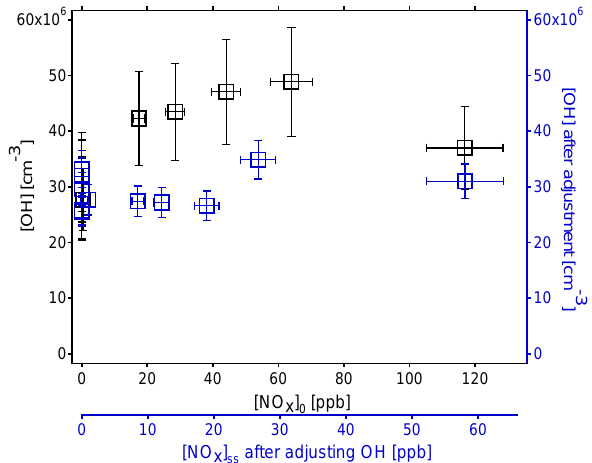
Figure 8. Measured SOA yield (black diamonds) and measured OH concentration (blue squares) as a function of initial NO x concentra- tion for α -pinene / NO x photooxidation experiments. Note that, due to the lower α -pinene concentrations, the x axis is not equivalent to the x axes of Figs. 5 and 7. In the sense of BVOC / NO x ratios, the NO x range scanned here is ∼ 3 times higher. The errors in [OH] and [NO x ] were estimated to be ± 15 and ± 10% respectively. The error in SOA yield was estimated from error propagation using the sum of the systematic error, correction procedure error and error in BVOC